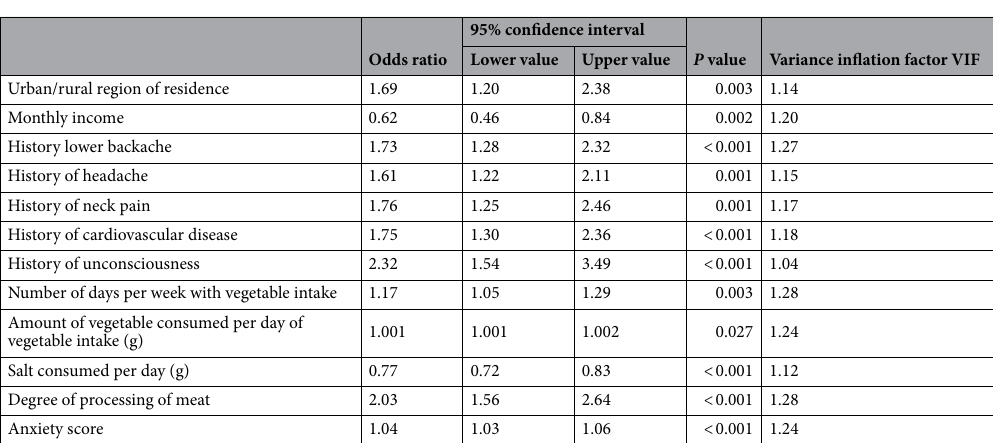
Table 5. Associations (multivariable analysis) between the prevalence of osteoarthritis and other parameters in the Ufa Very Old